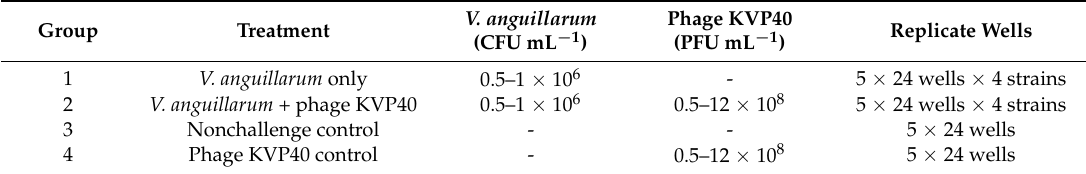
Table 3. Experimental design and addition V. anguillarum and phage